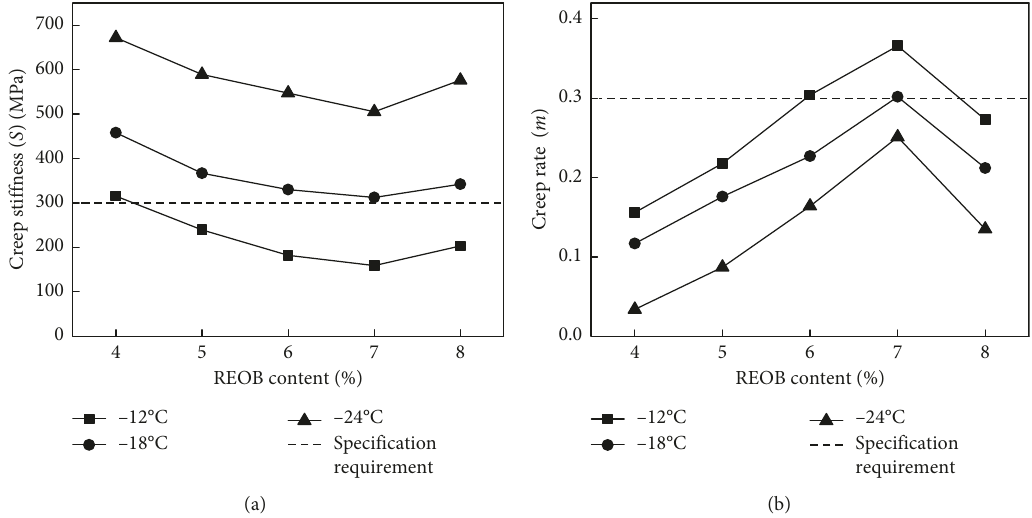
Figure 5: Influence of REOB content on creep stiffness and creep rate of aged asphalt. (a) Creep stiffness. (b) Creep rate.